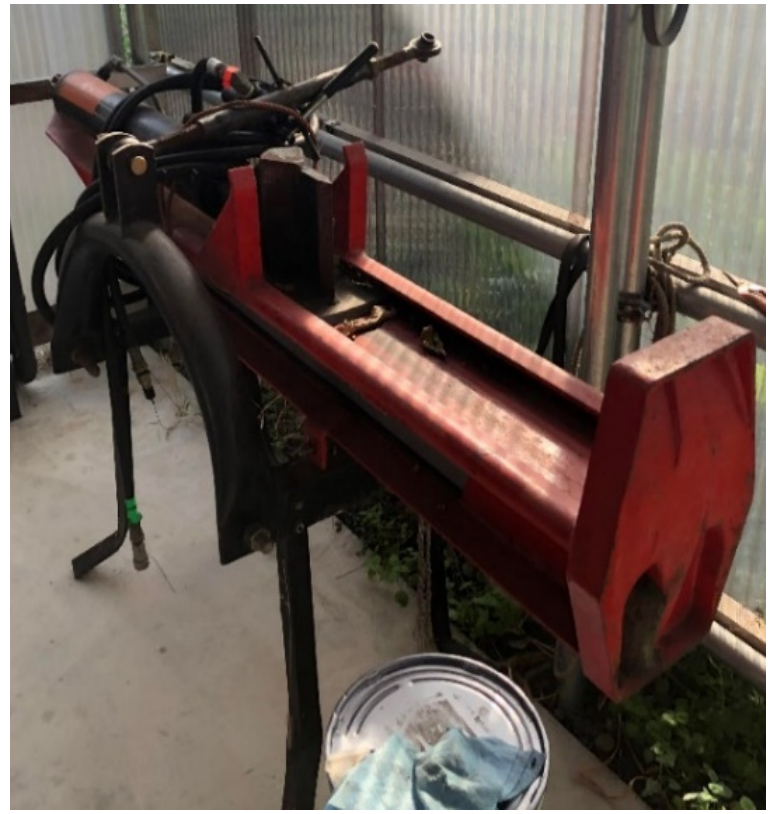
Figure 1. Powered wood splitter.